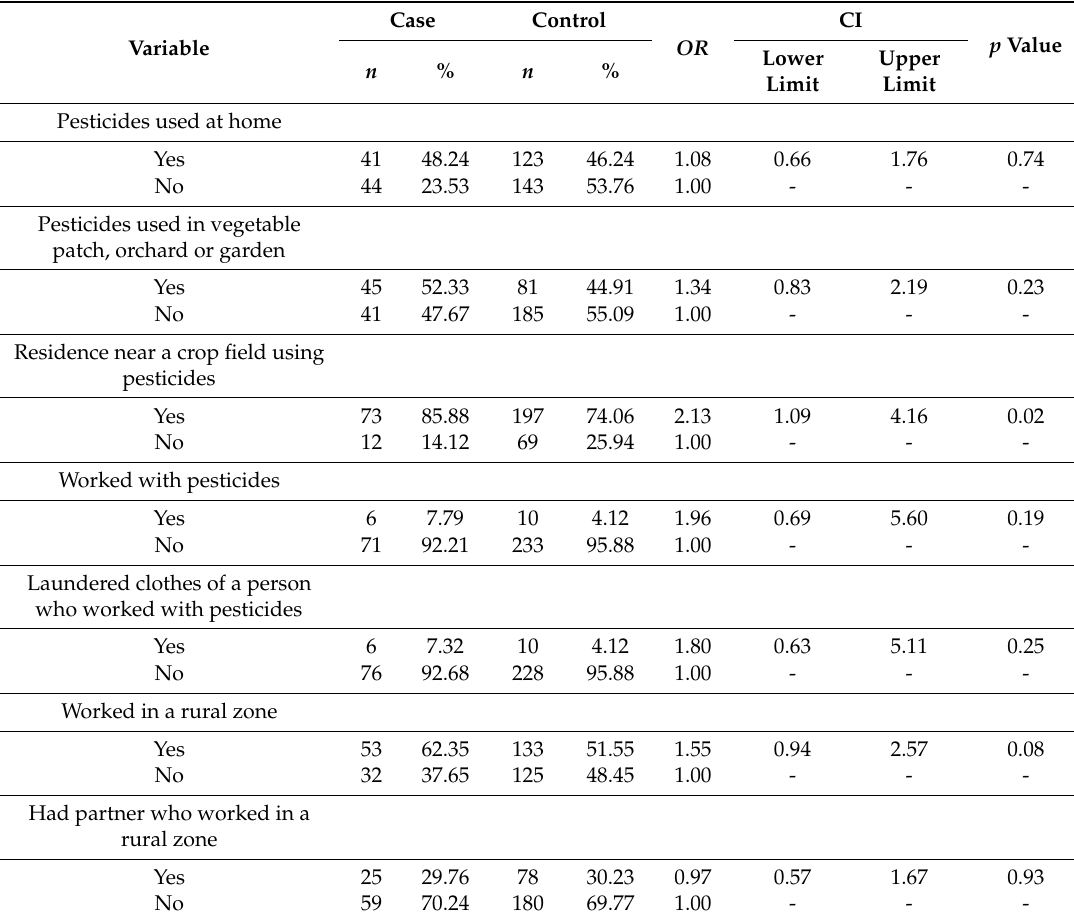
Table 3. Analysis of occupational and environmental exposure to pesticides and breast cancer, Rondon ó polis-MT, November 2017 to April 2018. Case Variable